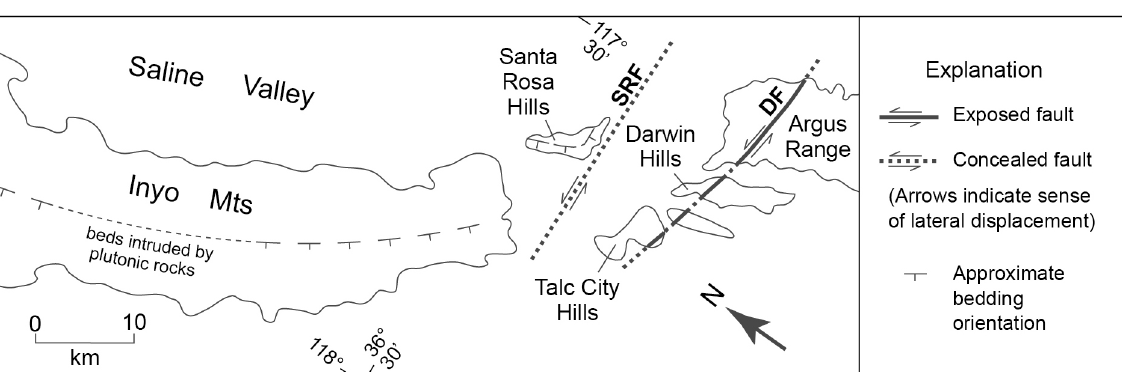
Figure 8. Structural features defining the Southern Inyo Structural Zone (SISZ) [69,72]. Note bending in the southern Inyo Mountains and the Santa Rosa Hills. Strike and dip symbols indicate approximate bedding orientation. Dashes in Inyo Mountains extend trends through plutonic rocks. DF = Darwin Fault; SRF = Santa Rosa Fault.